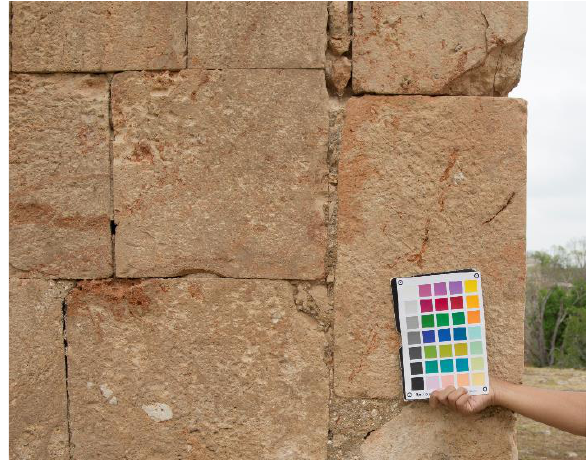
Figure 3. Using a color checker chart during the photogrammetric survey in Uxmal.